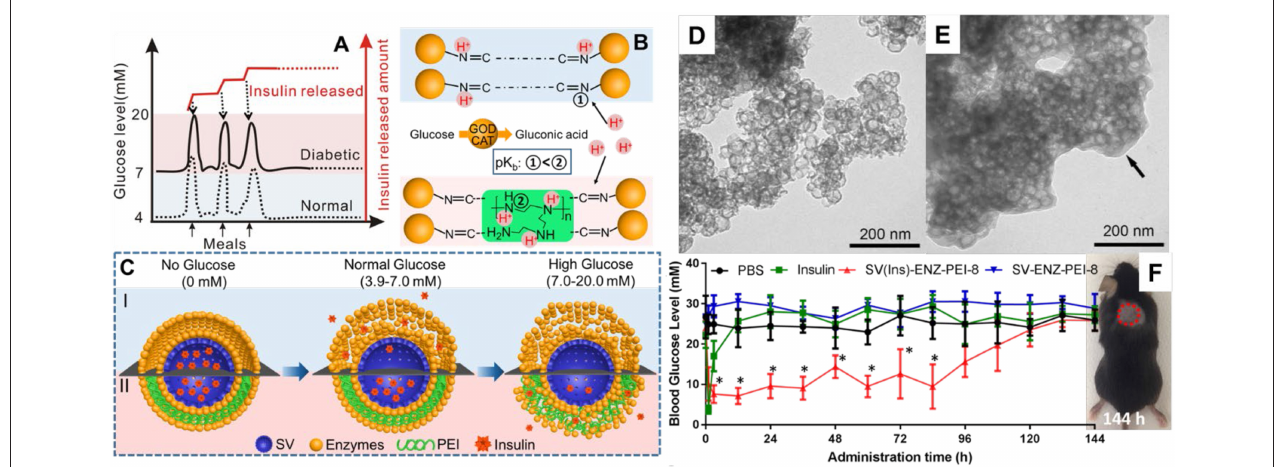
FIGURE 5 | MSNs based glucose responsive insulin delivery system (A–C) . Hollow MSNs (D) was used to loaded insulin and functionalized with glucose responsive layers through enzyme-polymer layer-by-layer coating strategy (E) . In vivo studies showed MSNs based nanosystem enables a fast glucose response insulin release and regulates the glycemia levels in a normal range up to 84h with a single administration (F) . Reproduced with permission from Xu et al. (2017), The American Chemical Society.